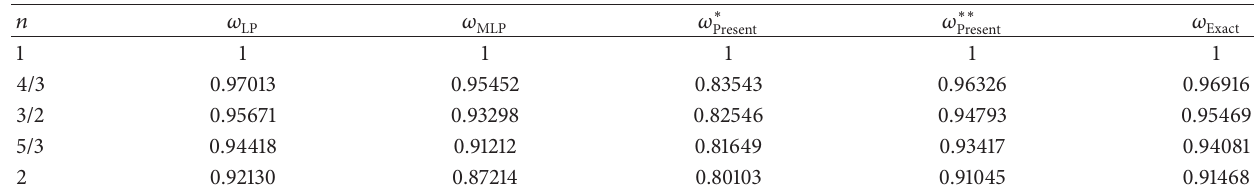
Table 2: The frequencies 𝜔 given by (16) as a function of various values of the parameters 𝑛 and 𝐴 = 1 .